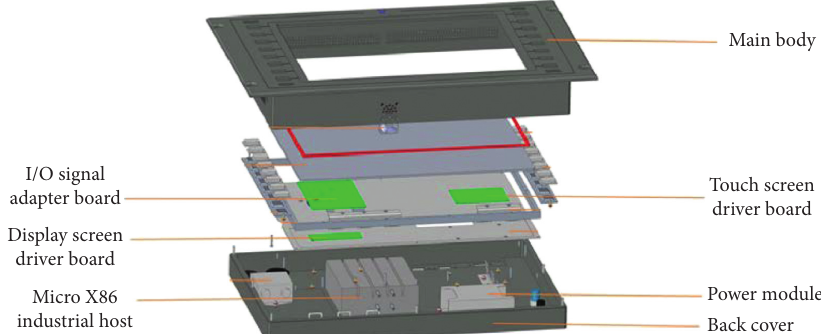
Figure 6: Three-dimensional assembly drawing of the simulator.